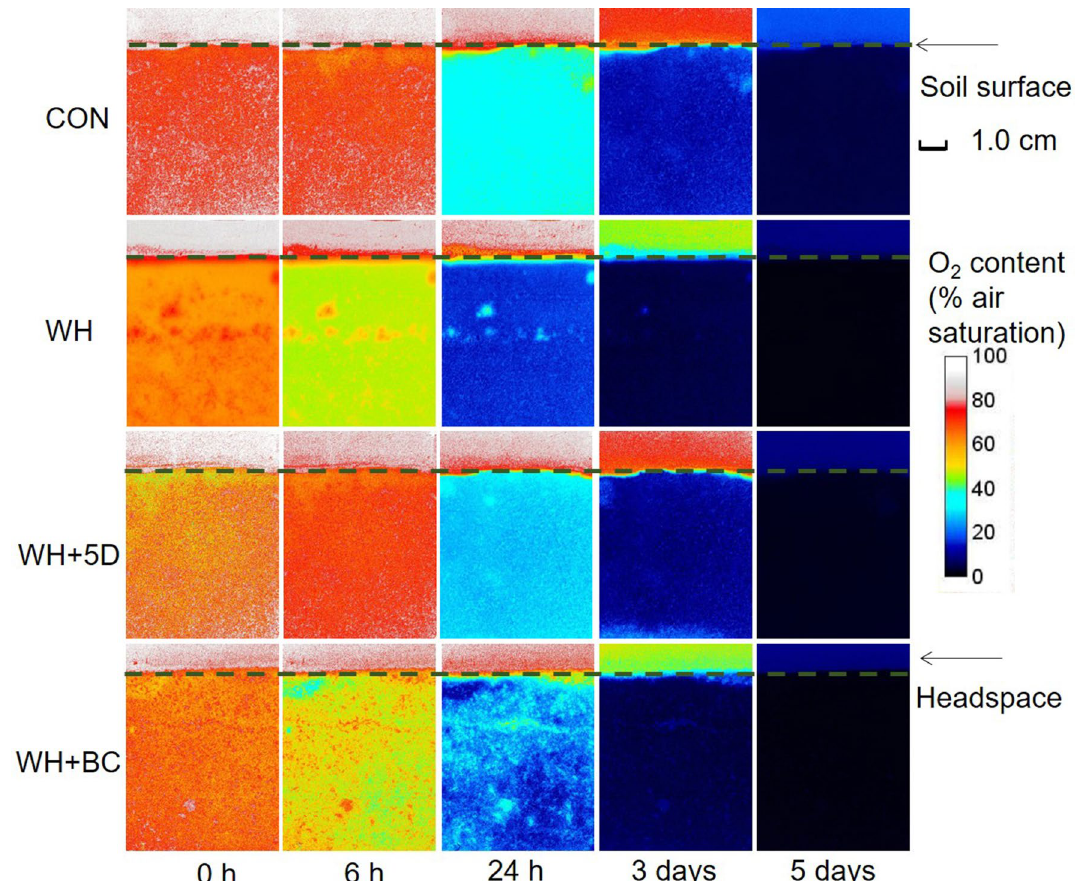
Figure 3. Selected images of O 2 content in soil and headspace after different straw applications. Images are one representative example of the three replicates. CON: soil without any amendments; WH: soil amended with wheat straw; WH + 5D: soil amended with wheat straw 5 days before the BSD treatment; WH + BC: soil amended with wheat straw and